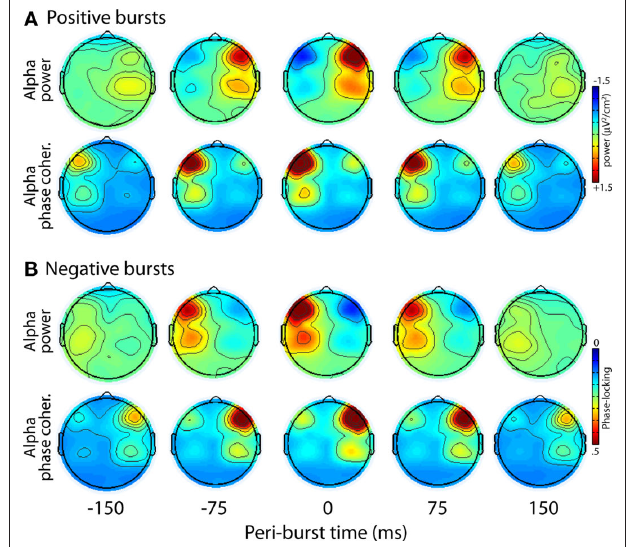
FIGuRE 10 | Inter-burst phase coherence as a function of MDD status for positive bursts. The effect of MDD status is episode dependent, with only currently depressed individuals showing enhanced inter-burst phase coherence, and only for left frontal activity.